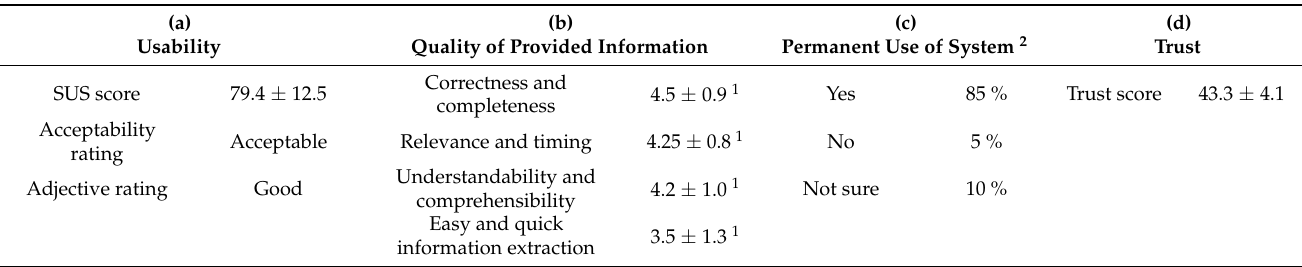
Table 6. General system assessment: (a) system usability; (b) quality of provided information; (c) subjects’ readiness for permanent system usage; (d) trust in robot.